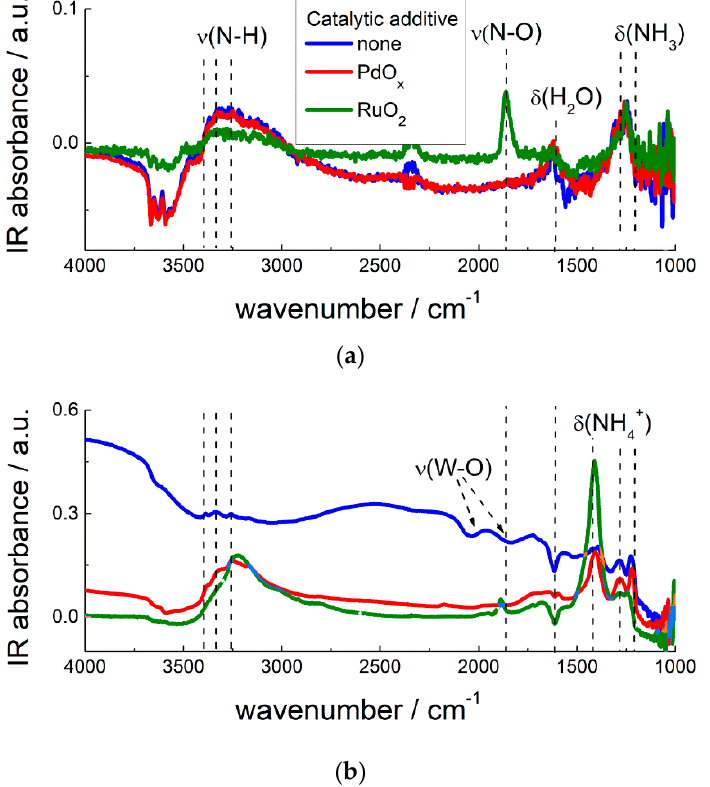
Figure 24. DRIFT spectra of pristine and functionalized by noble metal additives nanocrystalline SnO 2 ( a ) and WO 3 ( b ) exposed to NH 3 (100 ppm ( a ); 200 ppm ( b )) at 200 °C for 1 h. Adapted with permissions from ref. [75] copyright 2018 Elsevier; ref. [118] copyright 2015 American Chemical Society.